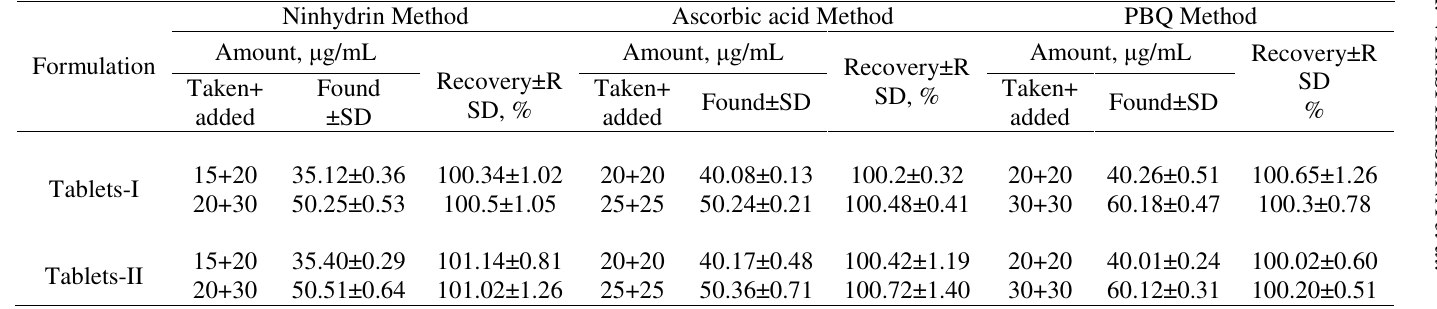
Table 3. Determination of Alfuzosin in pharmaceutical formulation by standard addition